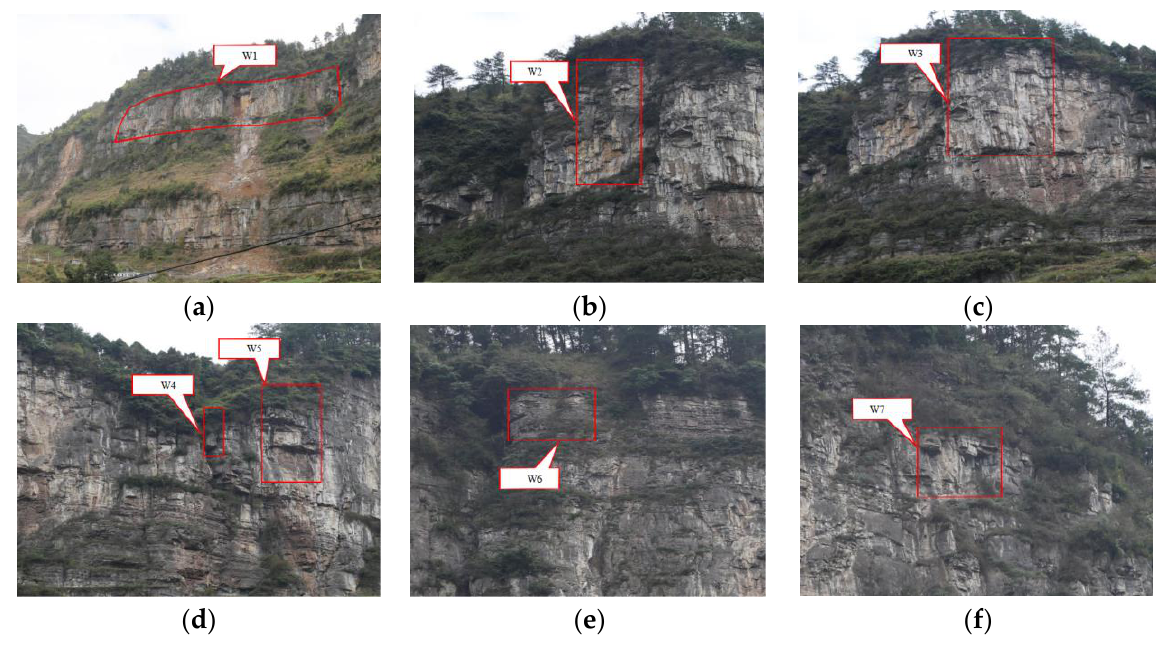
Figure 1. Profile of perilous rock. ( a ) W1 perilous rock; ( b ) W2 perilous rock; ( c ) W3 perilous rock; ( d ) W4, W5 perilous rock; ( e ) W6 perilous rock; ( f ) W7 perilous rock. The details of the scope, scale, and shape of the perilous rock are shown in Table 1. Table 1. Statistical table of morphological characteristics of collapse.